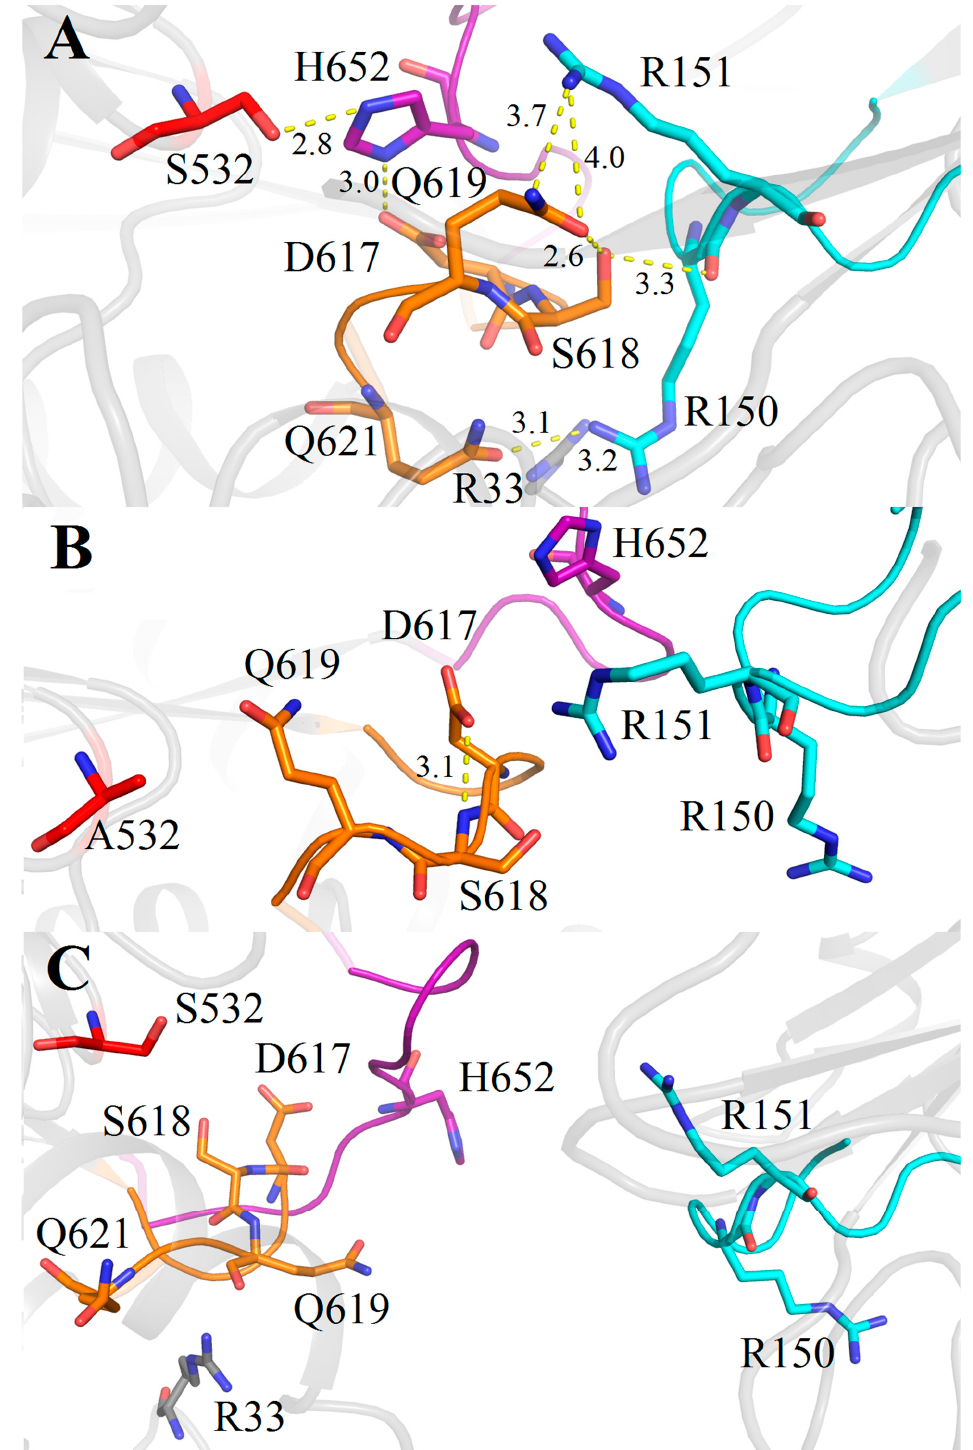
Figure 7. Cartoon/ribbon presentation of the assembled and dissembled catalytic triad in the closed ( A ), intermediate ( B ), and open ( C ) states of SpOpB. Catalytic residues S532, H552, and D617 (together with neighboring residues) are colored in red, magenta, and gold, respectively. The covalently bound inhibitor is omitted. The H- and D-loops are in the same color as the respective catalytic residues. The R150 and R151 pair and the respective β -propeller loop are colored in cyan. All interactions described in the text are shown by yellow dashed lines; distances are given in